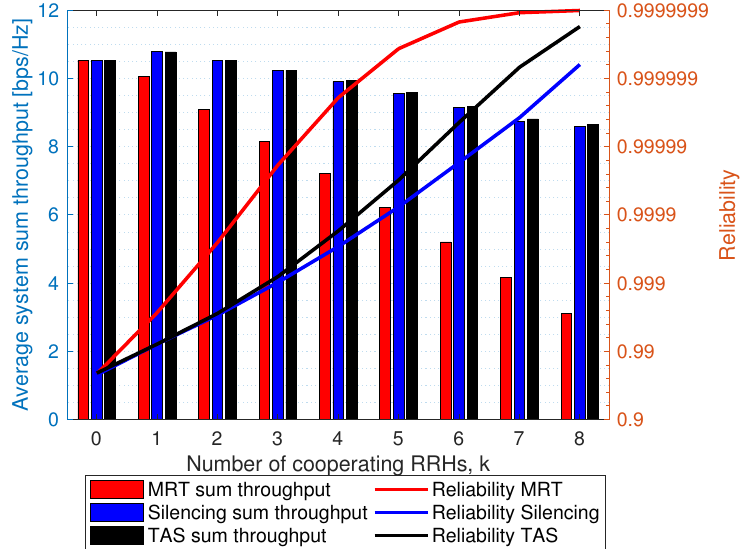
Figure 10. Trade-off analysis between reliability and average system sum throughput for silencing, TAS with silencing and MRT schemes as a function of k . We set θ = 0